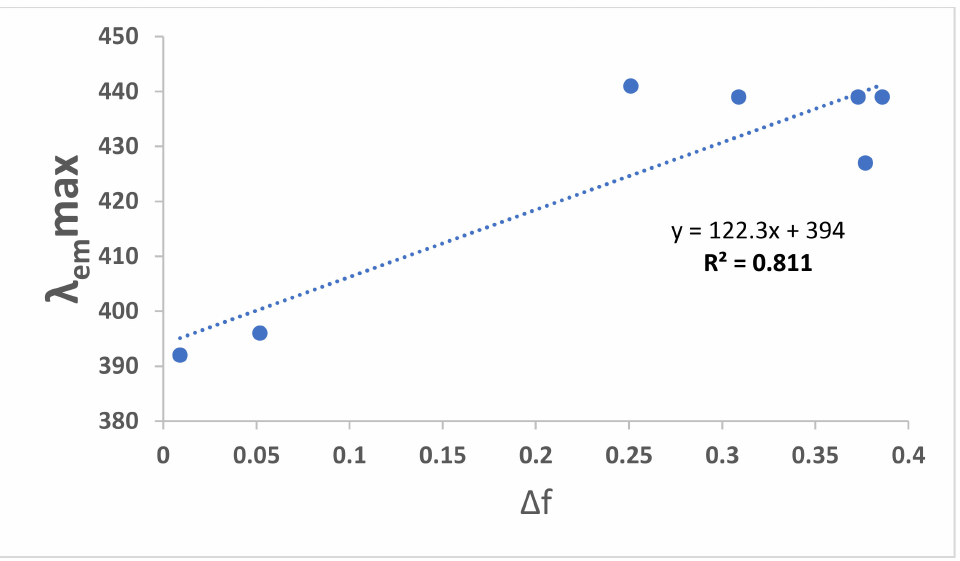
Figure 10. Effect of solvent relative polarity on λ em max of 7.6 × 10 − 5 M of 2-amino-4-hydroxy-6- (4-hydroxy-2-oxo-2H-chromen-3-yl)nicotinonitrile 4